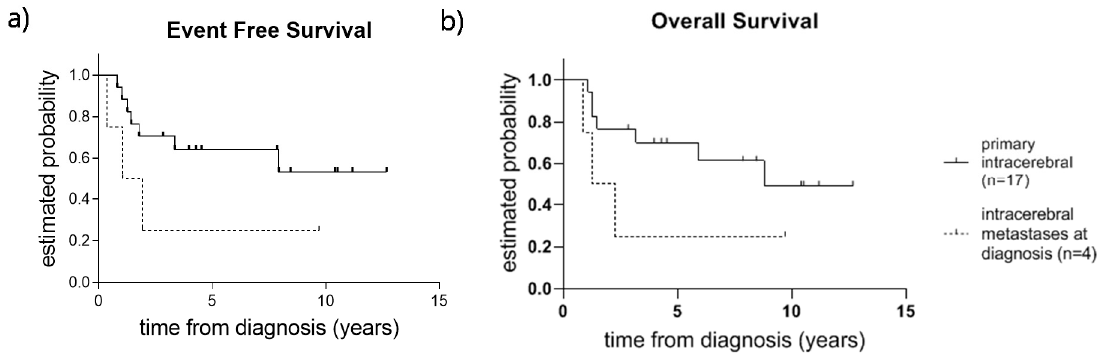
Figure 1. ( a ) Event-free survival (EFS) and ( b ) overall survival (OS) in patients with primary intracranial EwS ( n = 17) and extracranial EwS patients with intracerebral metastases at diagnosis ( n = 4).